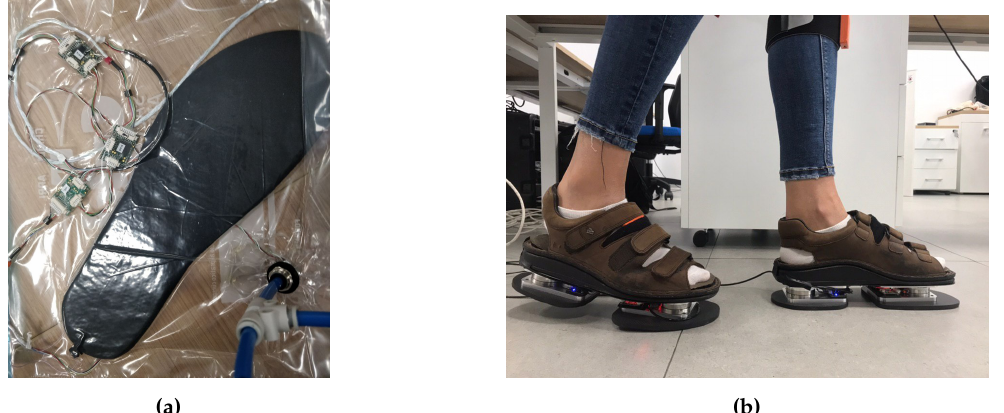
Figure 5. ( a ) Vacuum bag experiment. The pressure inside the bag was reduced by using a vacuum pump. ( b ) Sensorised shoes equipped with force/torque (FT) sensors and insoles.